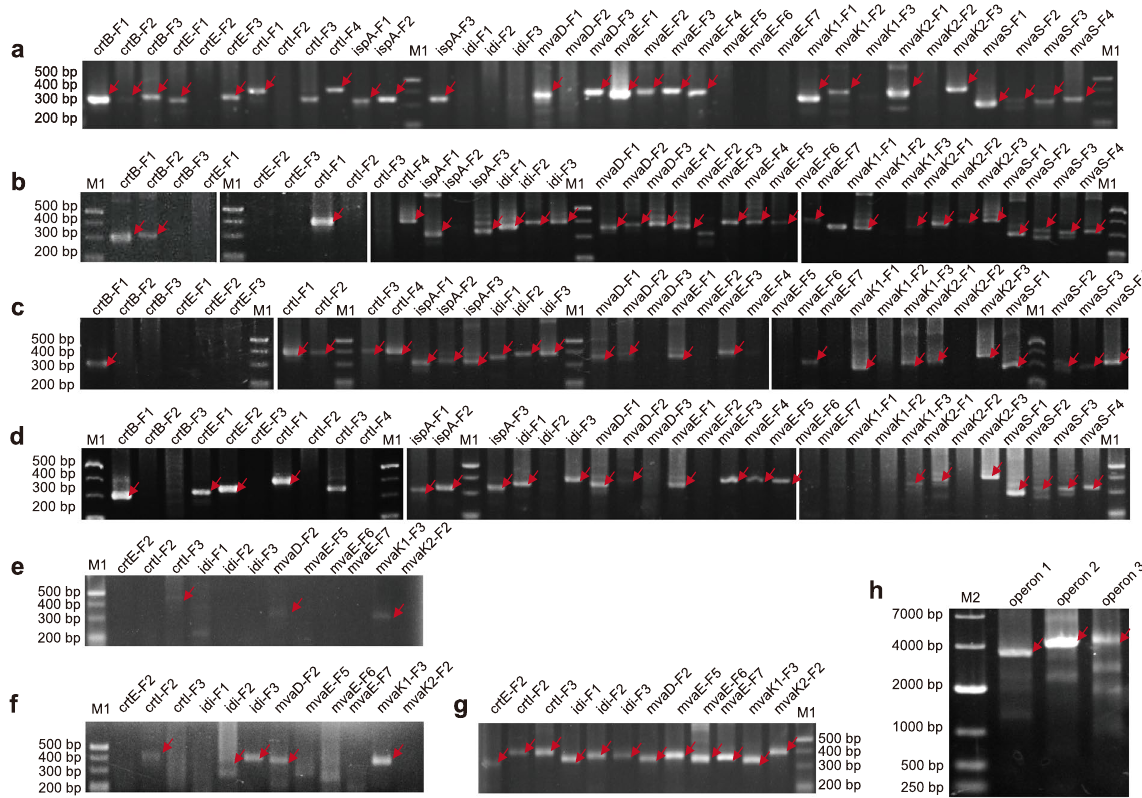
Figure 6. De novo synthesis of lycopene biosynthetic pathway. Fragments were assembled by multiplex assembly using error-depleted oligo pools of various throughputs and half-specific primer pairs. Thirty six ( a ), 3–4 ( b ), 6–7 ( c ), and 17–19 ( d ) subpools were used in one assembly reaction and 24, 26, 24, and 22 fragments were assembled, respectively. ( e ) Fragment detection in the assembly (36 subpool/reaction) with full-specific primer pairs. ( f ) Fragment detection in the assembly (12 subpool/reaction) with half-specific primer pairs. ( g ) Fragment detection in the assembly (12 subpool/reaction) with full-specific primer pairs. ( h ) Operons assembled by Gibson assembly. M1, 20 bp DNA ladder (TaKaRa Bio); M2, 2 K plus II DNA ladder (TaKaRa Bio). Red arrows indicate target fragments. OLS, oligo subpool; F,